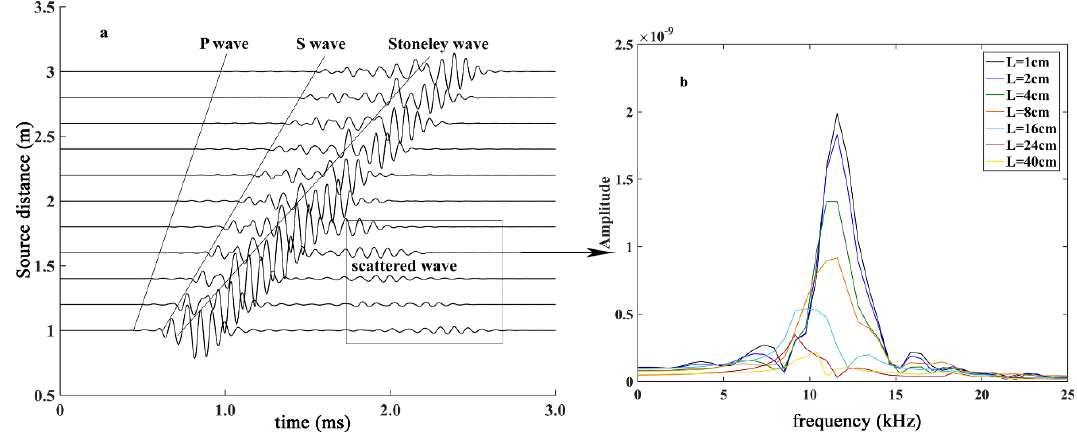
Figure 12. Full-wave acoustic-logging in cave formation. ( a ) shows the scattered wave in the cave formation. ( b ) shows the frequency spectrum of the scattered wave. Radius of cave is 2 cm. L represents the distance of the cave. Center frequency of source is 10 kHz.